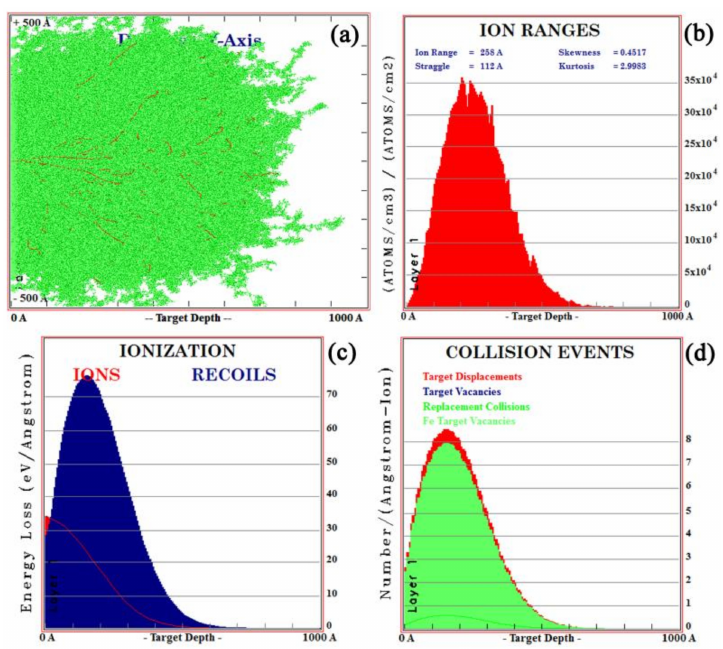
Figure 3. TRIM simulation of yttrium ion implantation for the ( a ) ion beam pattern, ( b ) ion ranges, ( c ) ionization distribution of ions, and ( d ) collision